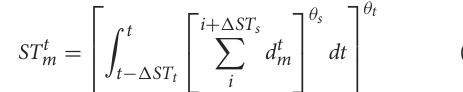
(ST) cores. An ST core aims to reduce the background noise of the DVS camera and enhance the key ST